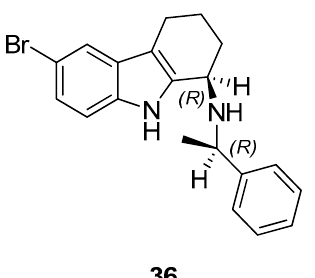
Figure 16. Structure of (1 R )-6-bromo- N -[(1 R )-1-phenylethyl]-2,3,4,9-tetrahydro-1 H -carbazole-1-amine ( 36 ).